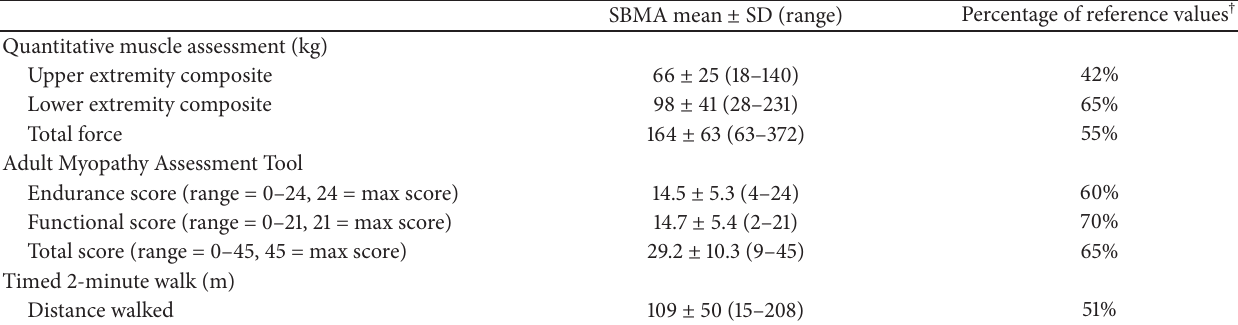
Table 1: Physical performance assessments in patients with SBMA.